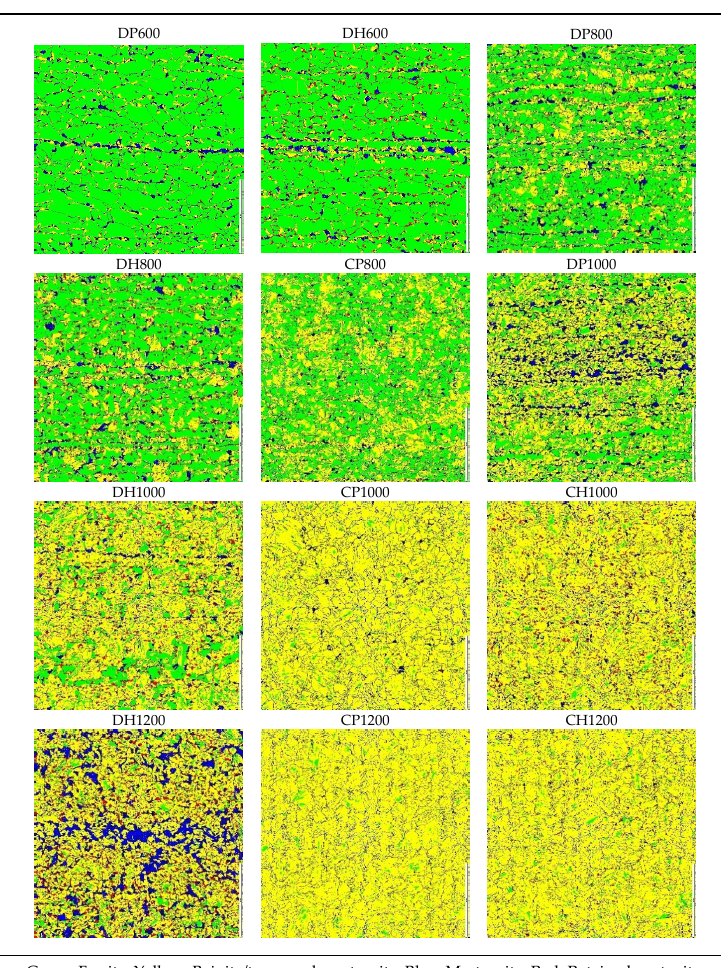
Table A2. Microstructure (EBSD measurements).